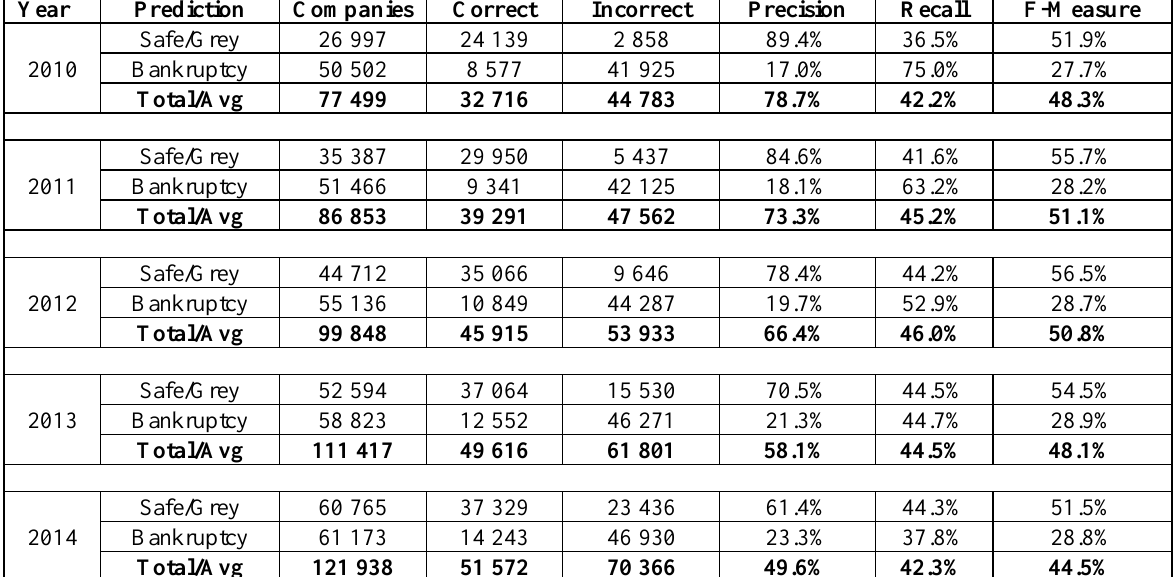
Table 3. Evaluation of Bankruptcy prediction based on Altman’s